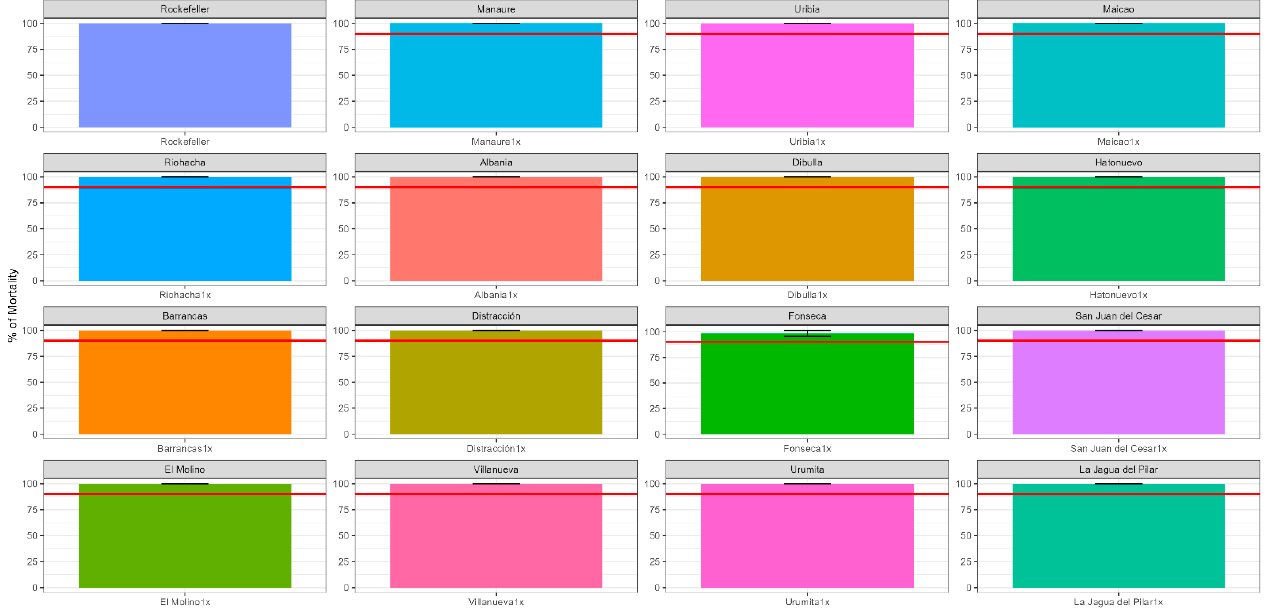
Figure 3. Mortality (with standard deviation) of Ae. aegypti following exposure to 1 × DD of deltamethrin in bottle bioassays. The red lines indicate the resistance threshold (90% mortality).